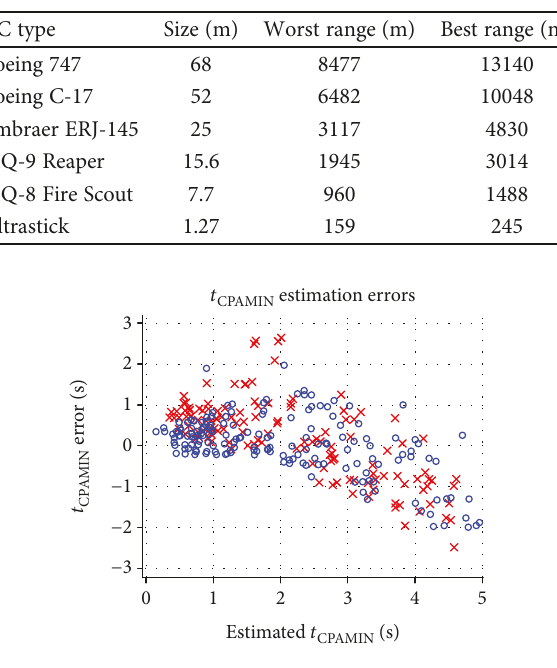
Figure 13: Estimation errors of 3D TTCPA (red x: close encounters; blue circle: far encounters).